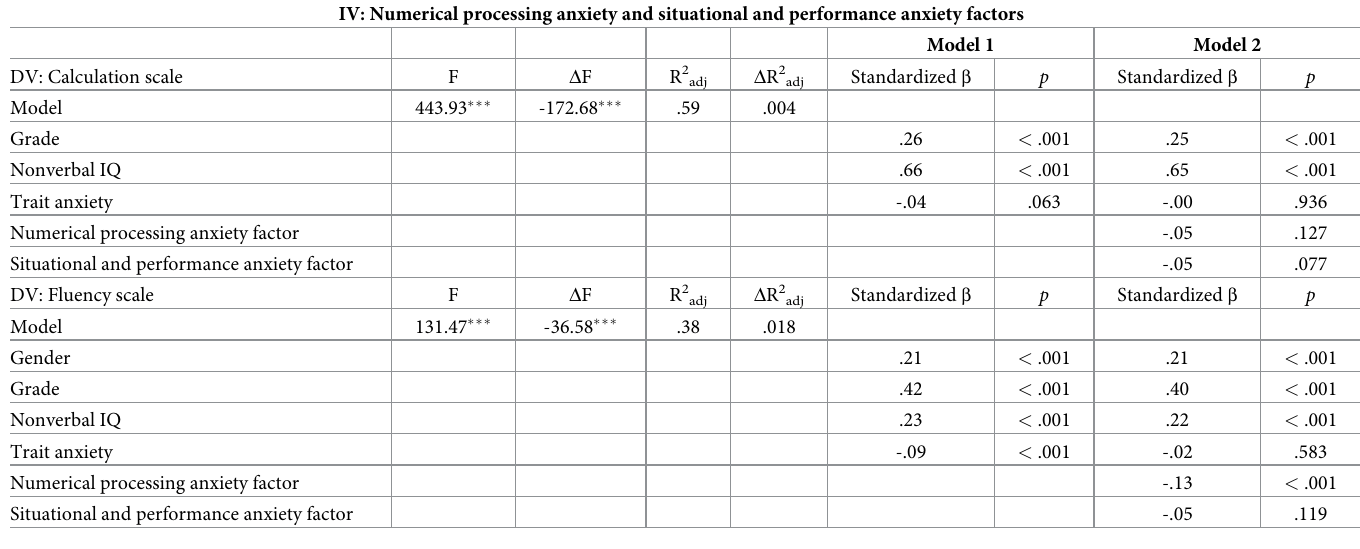
Table 6. Hierarchical regressions predicting WJ-III scale scores with numerical processing anxiety and situational and performance anxiety factors as independent variables. IV: Numerical processing anxiety and situational and performance anxiety